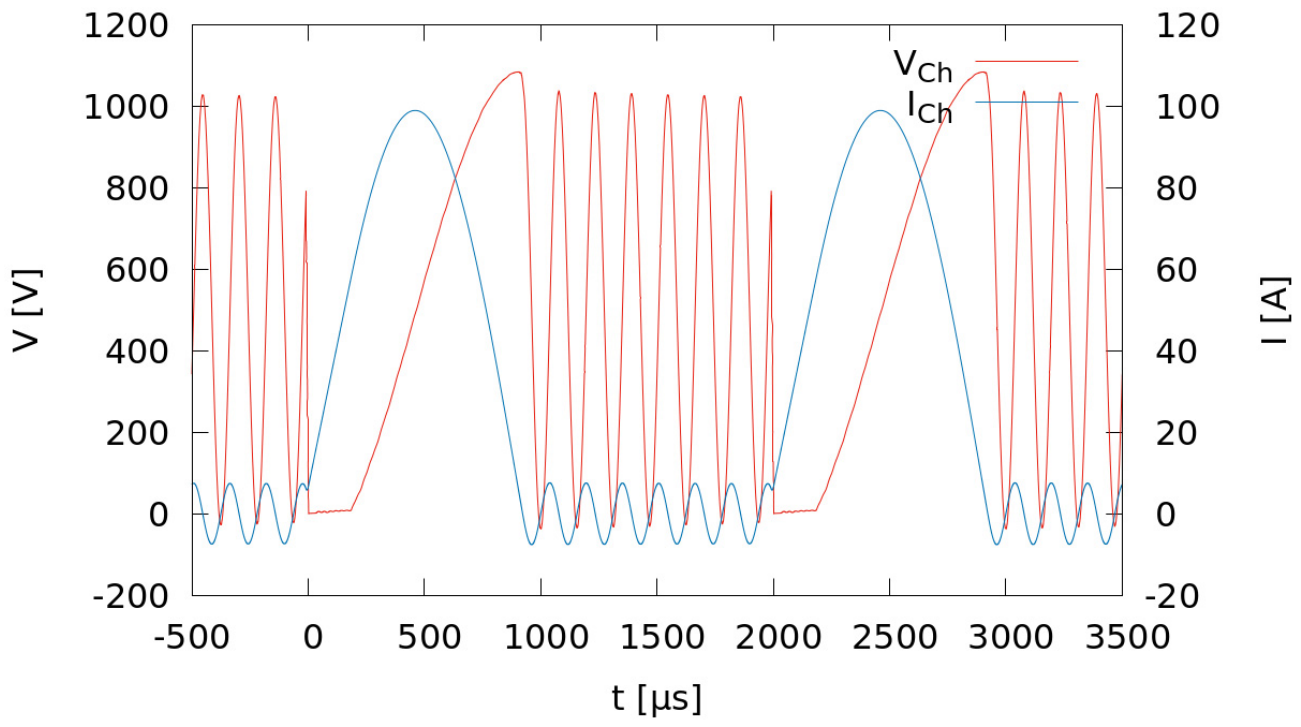
Figure 14. Charging voltage V ch and the charging current I ch at the charging input terminal of the generator, on-time of the solid-state switches: t on = 200 µs.